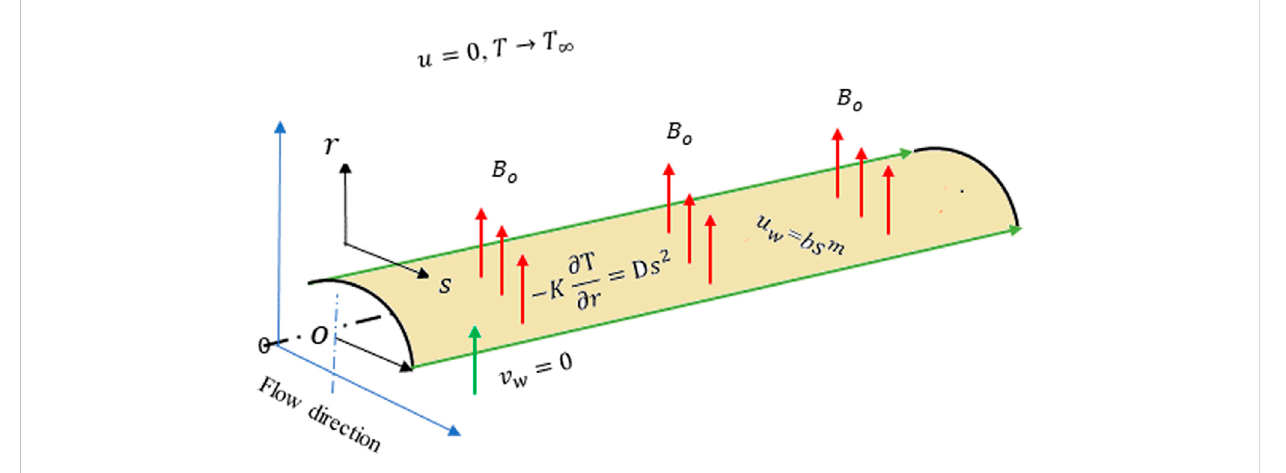
Geometry of the physical